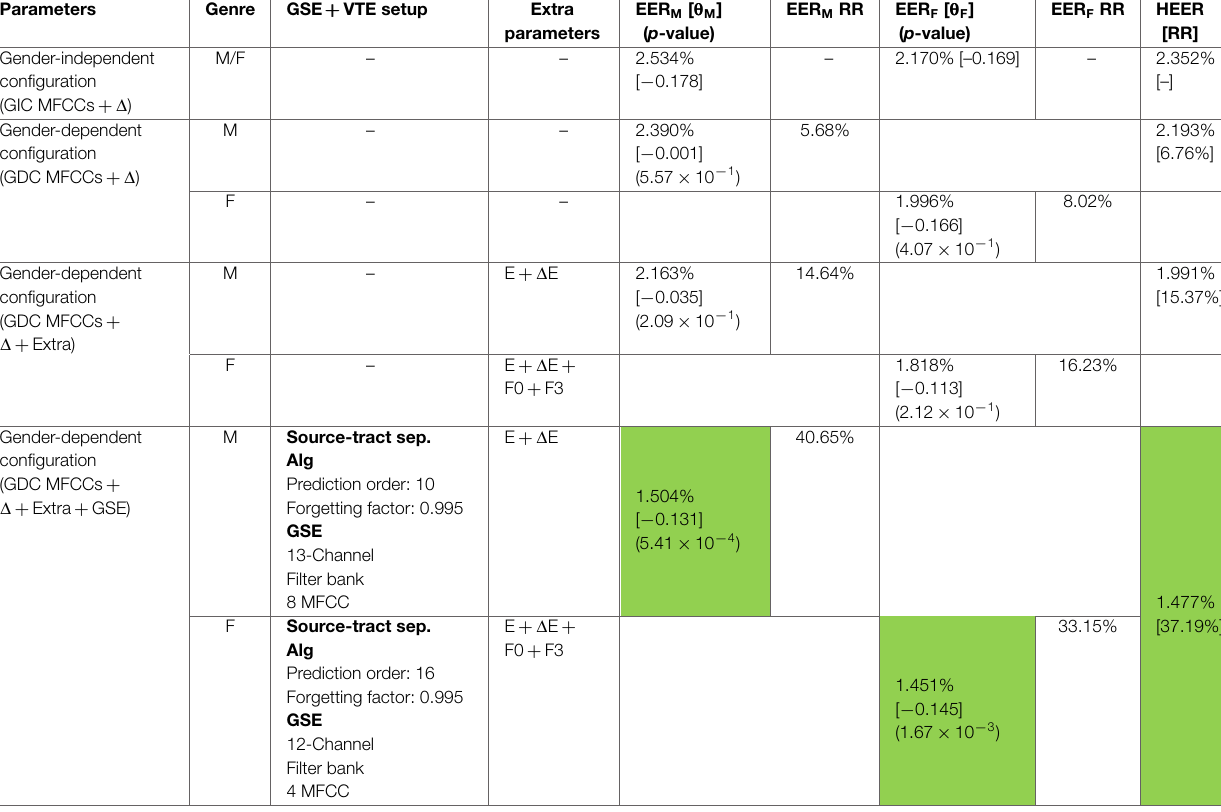
The results highlighted in green, are the ones achieving higher recognition rates.